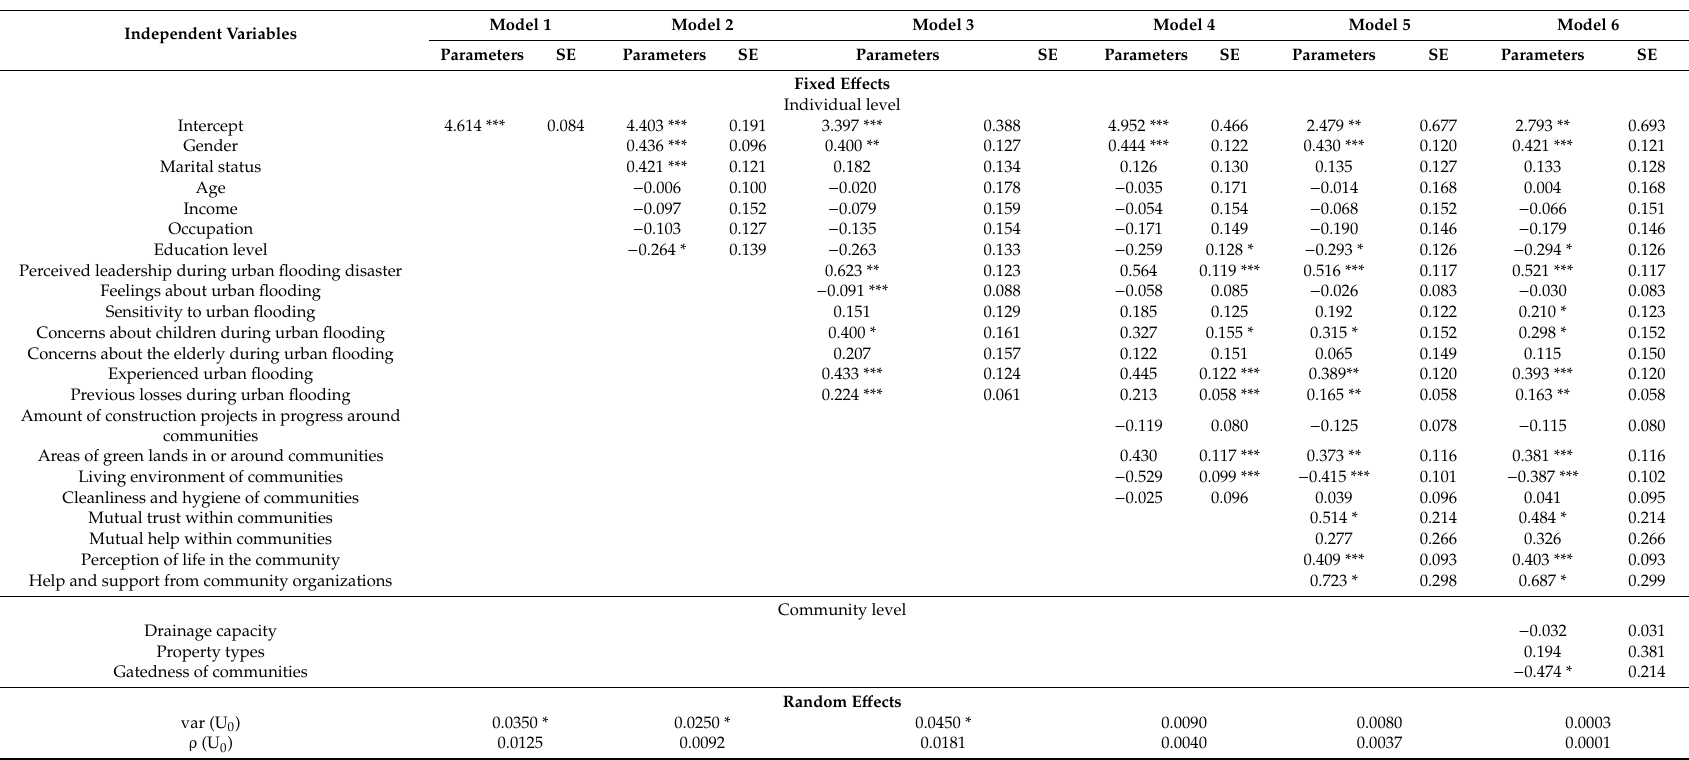
Table 6. Estimations of the determinants of individual